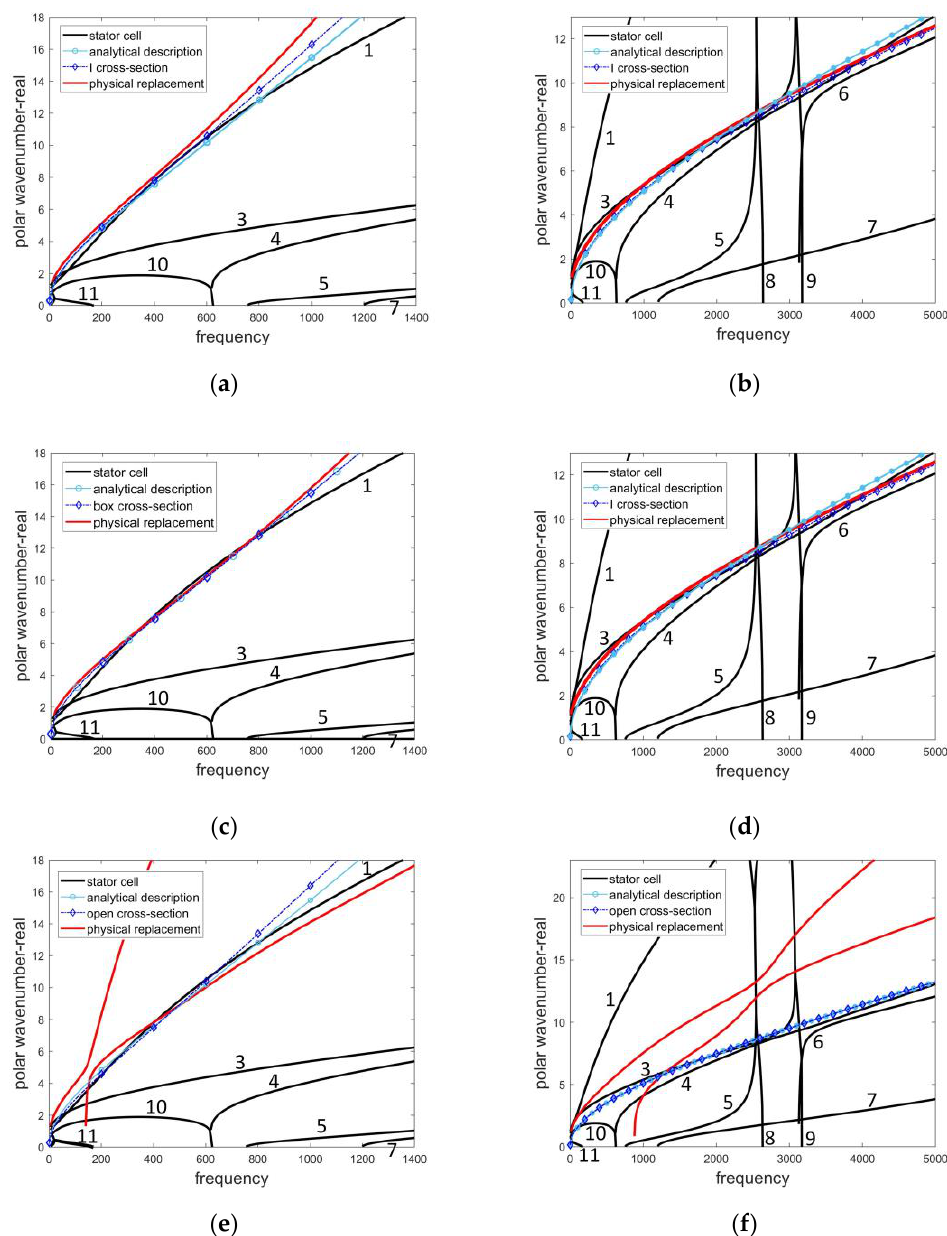
Figure 12. Dispersion curves of physical replacements with ( a , b ) I, ( c , d ) box, and ( e , f ) open cross- sections. The black lines are numerical solutions of the pristine stator. The solid lines with circles are analytical solutions of the analytical descriptions. The dash dot lines with rhombuses are analytical solutions of the beams with the six cross-sections. The red lines are numerical solutions of physical replacements.